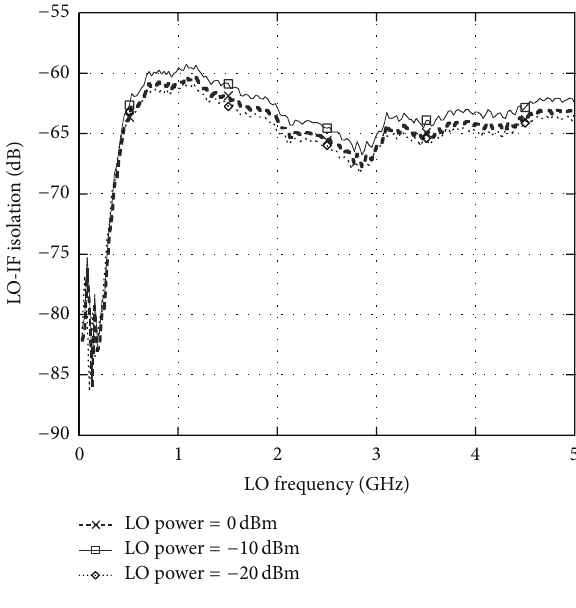
Figure 3: Measured LO-RF isolation. Figure 4: Measured LO-IF isolation.